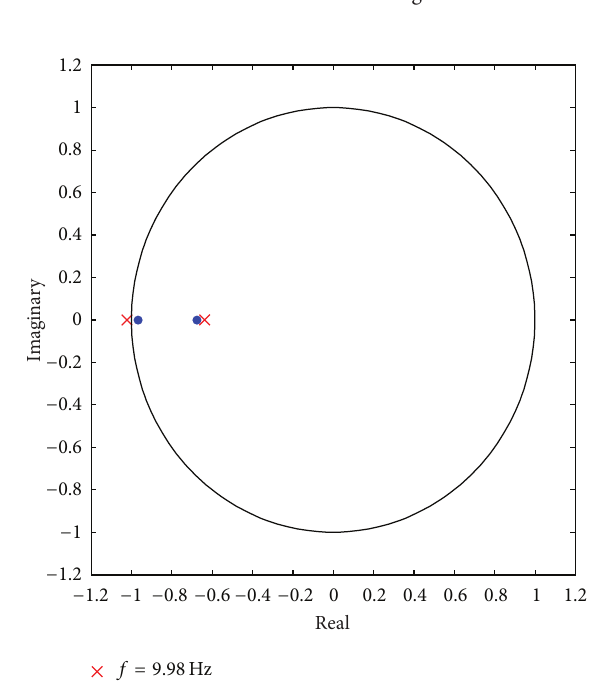
Figure 10: The bifurcation diagrams.